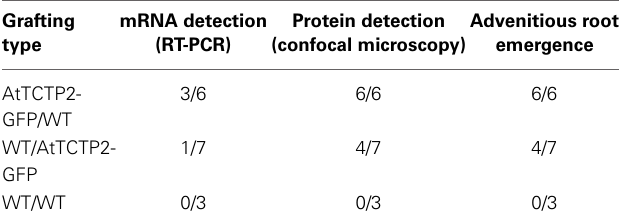
Table 1 | AtTCTP2-GFP long-distance movement as mRNA and protein in tobacco graftings.